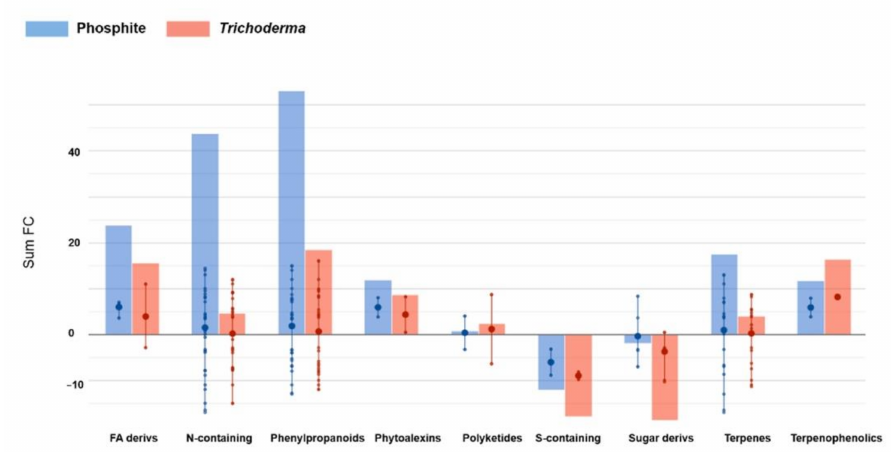
Figure 4. Biosynthetic pathways of secondary metabolites affected in plants treated with Trichoderma and phosphite. Differential metabolites and their fold-change (FC) values were elaborated using the Omic Viewer Dashboard of the PlantCyc pathway Tool software (www.pmn.plantcyc.com; Accessed on 3 December 2020). In each class, the large dot represents the average (mean) logFC of the metabolites. Small dots represent the individual logFC for each metabolite. The abbreviated subcategory names on the x-axis correspond to: FA derivs: fatty acid derivatives; N-containing: Nitrogen-containing secondary metabolism; S-containing: Sulfur-containing secondary metabolites; Sugar derivs: sugar